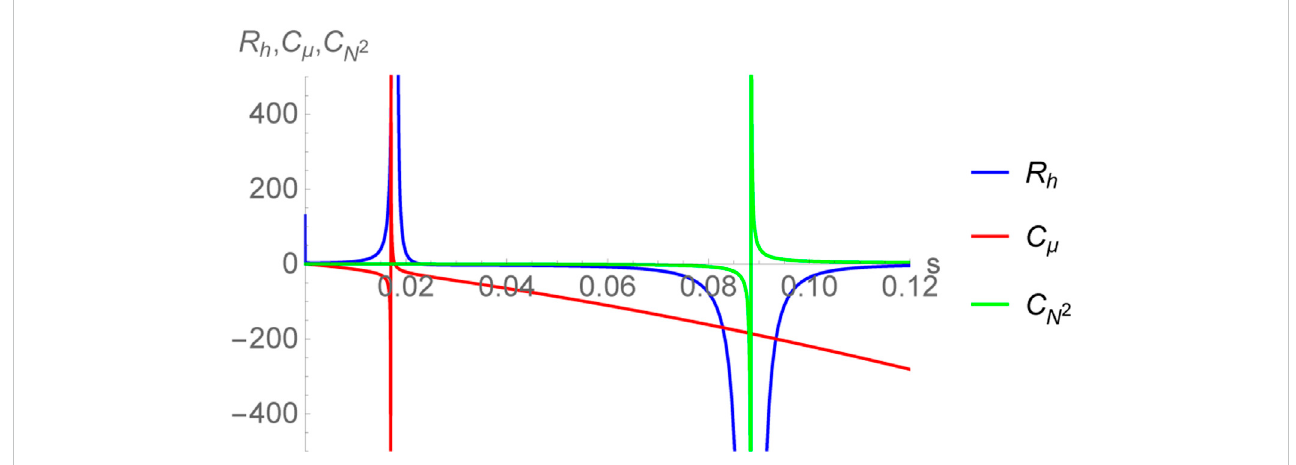
FIGURE 6 Plot of thermodynamic curvature R h together with the speci fi c heats C N 2 and C μ as a function of entropy density s